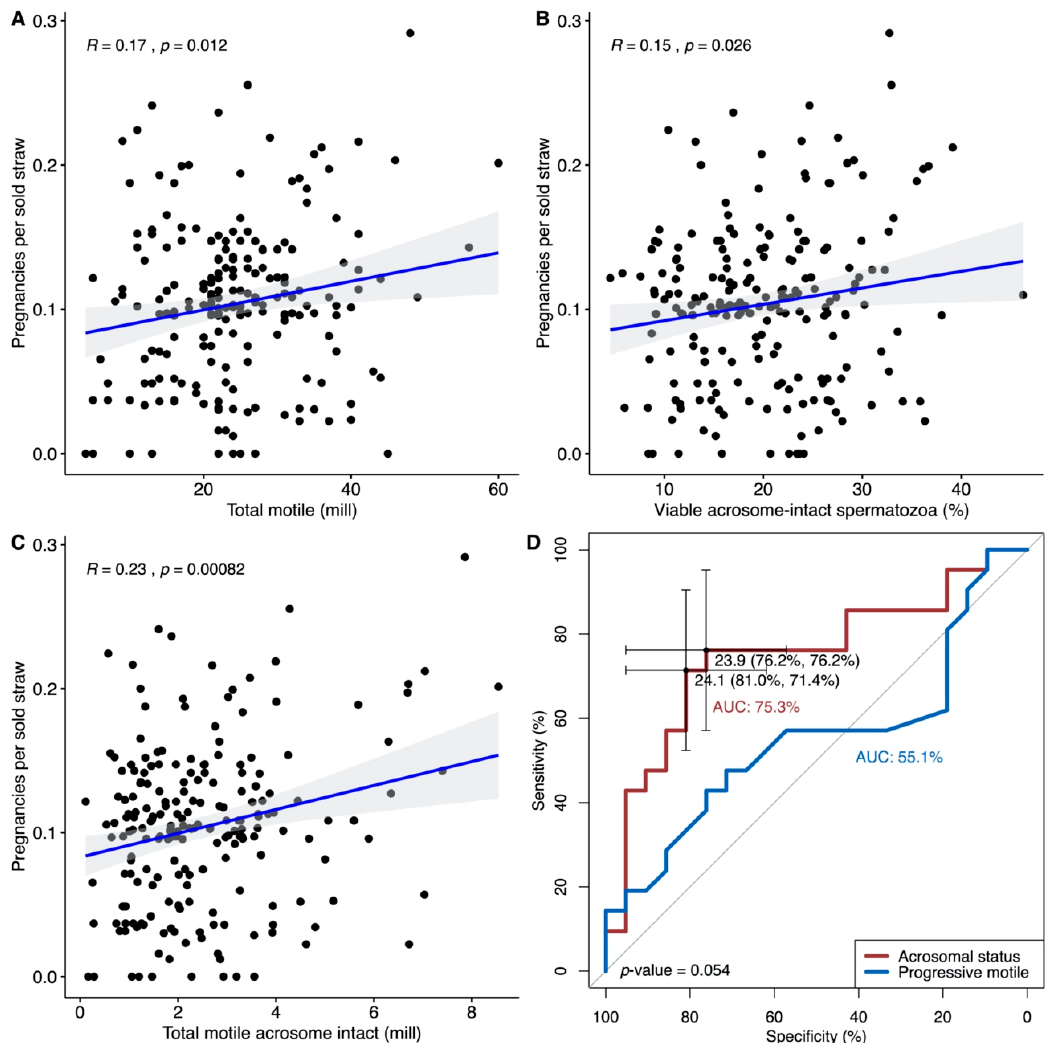
Figure 4. Correlations between frozen-thawed donor sperm samples ( n = 199) and the number of pregnancies per sold straw: ( A ) concentration of progressive motile spermatozoa, ( B ) percentage of viable acrosome-intact spermatozoa and ( C ) the total number of progressive motile spermatozoa with intact acrosomes (TMAI). The blue line is the best-fitted regression line with 95% confidence intervals in grey and the Pearson correlation coefficient ( R ) and p -value ( p ) are indicated in each plot. ( D ) ROC curve analysis of pregnancies per sold straw (top decile pregnancies per sold straw vs. the bottom decile) versus acrosomal status (red line) and progressive motile spermatozoa (blue line) of frozen-thawed samples. The p -value indicates the difference between the receiver operating characteristics (ROC) curves.